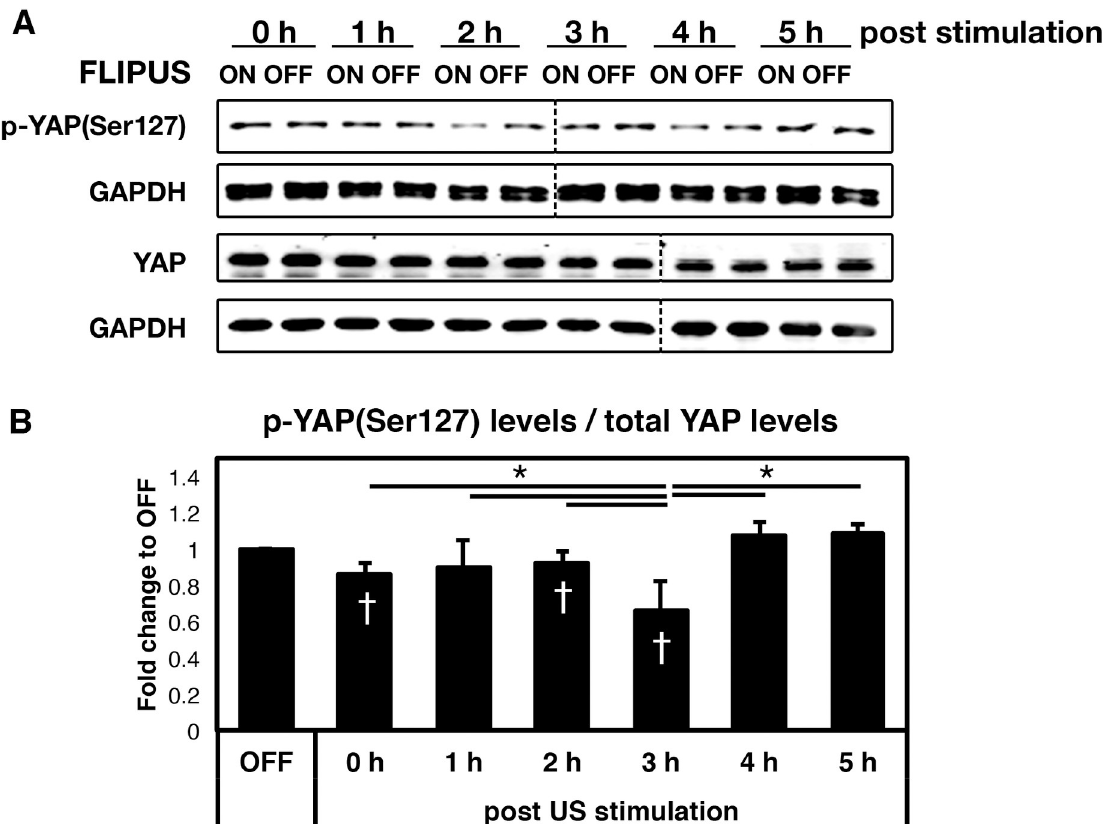
Fig 2. FLIPUS reduces phosphorylation of YAP at Serine 127. A: Representative picture of western blotting analysis of C2C12 cells harvested 0 h, 1 h, 2 h, 3 h, 4 h, and 5 h after 5-min FLIPUS stimulation. B: Near-infrared fluorescent intensity quantification of p-YAP (Ser127) levels normalized to total YAP levels of at least three biological replicates per time point presented as mean fold change of FLIPUS- treated cells compared to non-sonicated controls (OFF) of the corresponding time point ± SD � p < 0.05 indicate changes between the time points, † p < 0.05 indicate changes between FLIPUS-treated and untreated cells for a selected time point. The vertical dashed line represents location of the protein molecular weight marker, which was not included in the image.